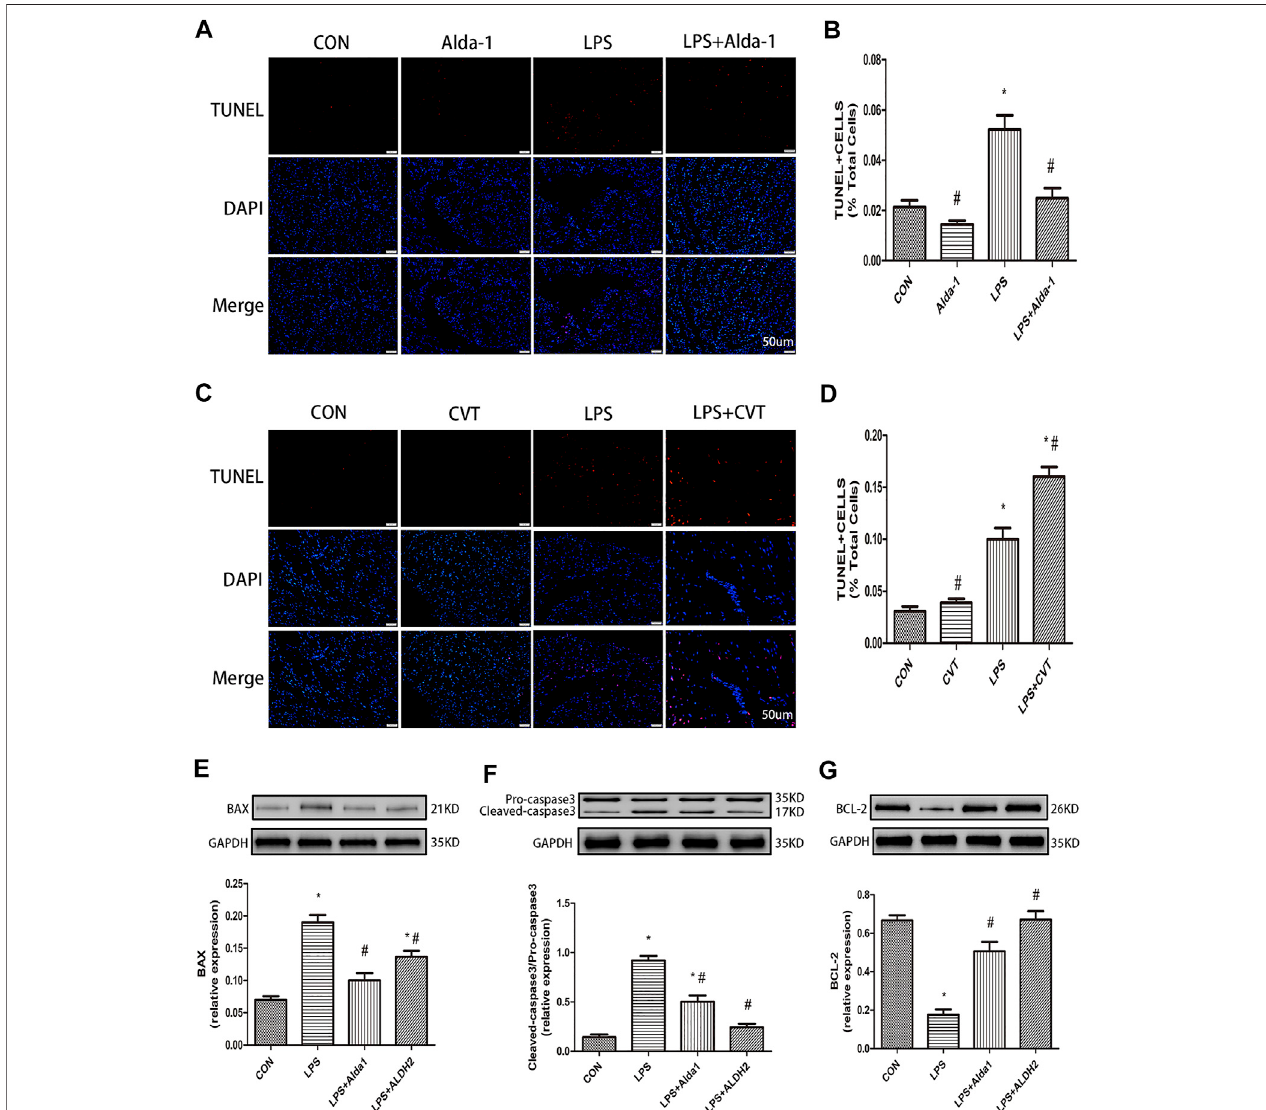
FIGURE 7 | Apoptosis in lipopolysaccharide (LPS)-treated mice. (A) TUNEL staining for myocardial cell apoptosis. (B) Ratio of apoptosis. Representative TUNEL staining images are shown (magni fi cation, × 400). Scale bar: 20 µm (C) TUNEL staining for myocardial cell apoptosis. (D) Ratio of apoptosis. Representative TUNEL staining images are shown (magni fi cation, × 400). Scale bar: 20 µm. Representative western blots and quanti fi cation of (E) BAX, (F) caspase 3, (G) BCL2, and glyceraldehyde 3-phosphate dehydrogenase (GAPDH; loading control). Data are the mean ± standard error of the mean. n (cid:1) 3 mice/group. Statistical analyses were performed by one-way analysis of variance, followed by Tukey ’ s post hoc test for multiple comparisons. * p < 0.05 vs. control (CON); # p < 0.05 vs. LPS.